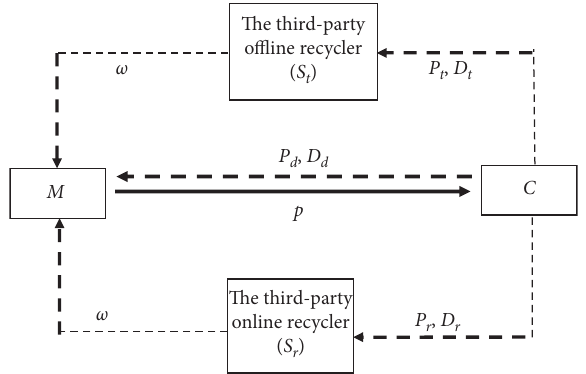
Figure 1: Recycling supply chain